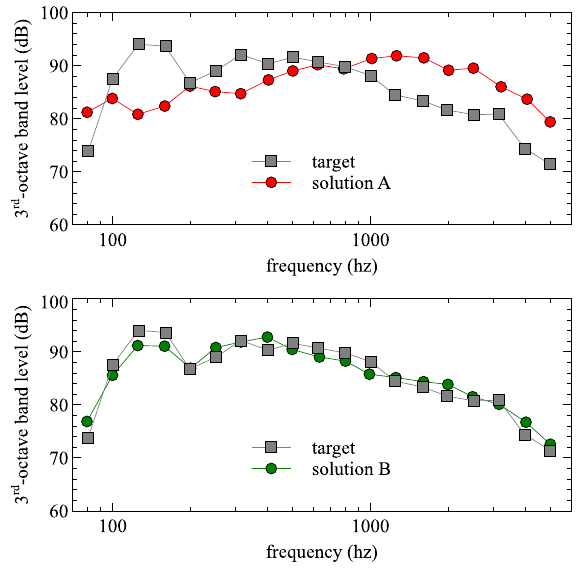
Figure 16: Spectral matching at flyover time for two landing proce- dures of a twin-engine, mid-range aircraft.